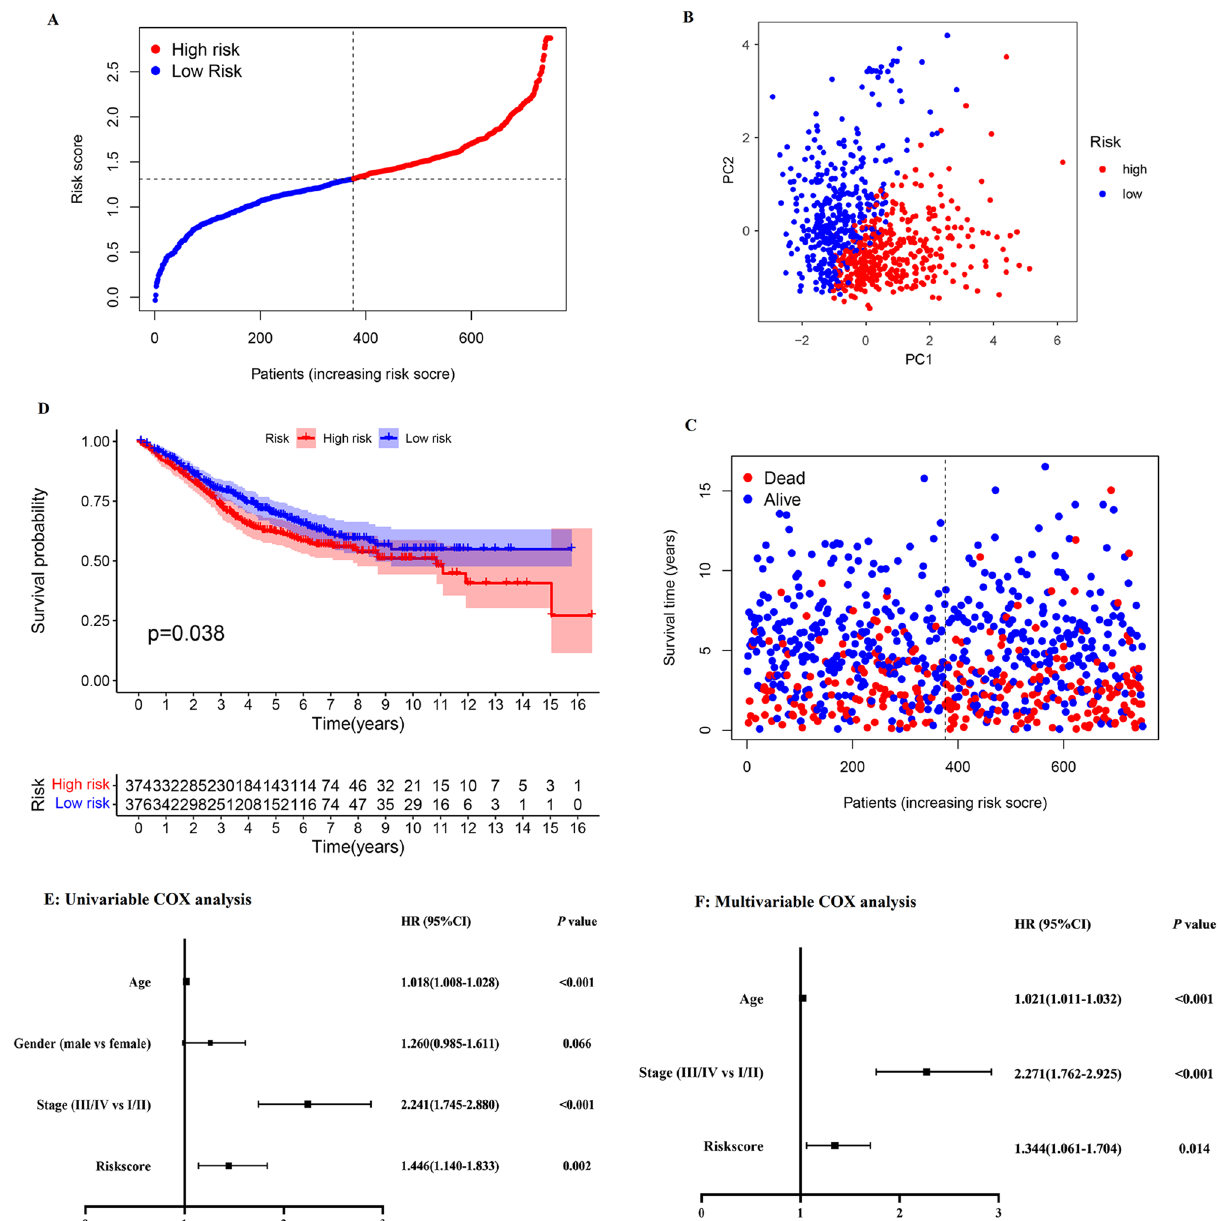
Figure 7. Validating the pyroptosis-related regulators signature. ( A )–( C ) Patients in GEO validating set were divided into low- and high- risk groups, and PCA and survival difference between two clusters have been showed. ( D ) KM analysis for GEO cohort to explore the survival difference between groups. ( E ) and ( F ) Univariable and multivariable COX analysis including clinical traits and risk score of patients in GEO validating